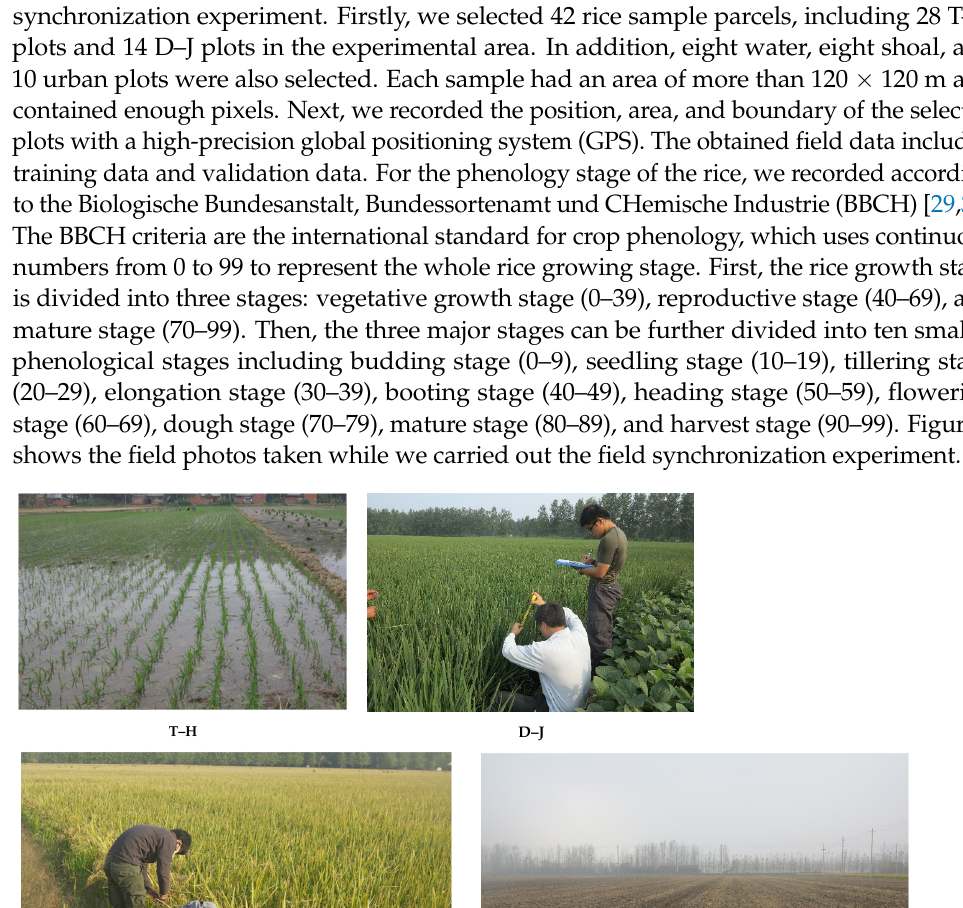
Table 1. Full polarization the SAR data parameters of the multi-temporal RADARSAT-2.